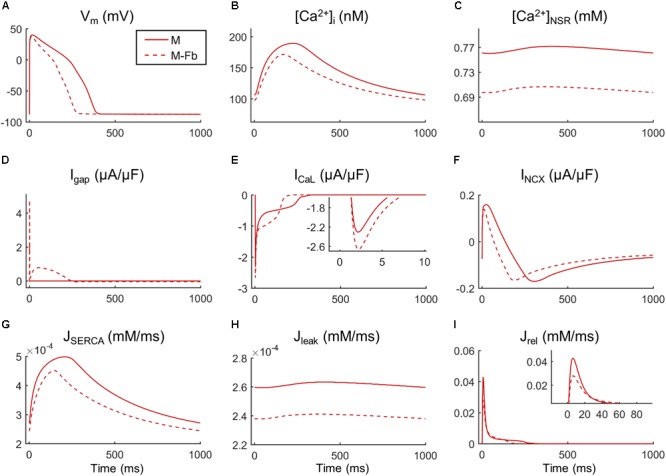
Main ionic properties and mechanisms in steady state of a failing myocyte interacting (M-Fb) or not (M) with fibroblasts. (A) Membrane potential (Vm), (B) intracellular Ca2+ concentration ([Ca2+]i), (C) sarcoplasmic reticulum (SR) Ca2+ concentration ([Ca2+]SR), (D) outward positive current circulating from the myocyte to the fibroblast (Igap), (E) L-type Ca2+ current (ICaL), (F) Na+/Ca2+exchange current (INCX), (G) SR Ca2+ uptake via SERCA pump (JSERCA), (H) SR Ca2+ leak (Jleak), and (I) SR Ca2+ release flux via ryanodine receptors (Jrel).